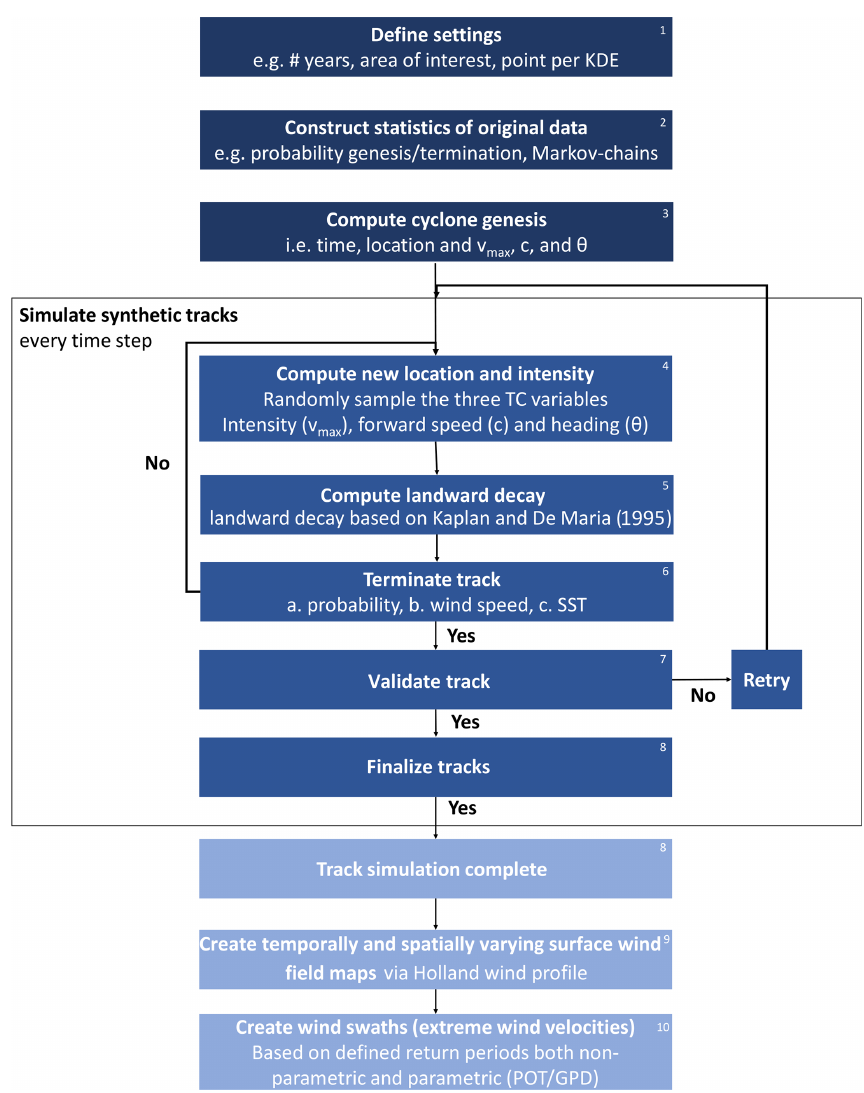
Figure 1. Flowchart of the track modeling procedure. Dark blue colors are pre-processing steps, blue colors the computational core of TC- WiSE and light blue post-processing steps. KDE stands for kernel density estimation, SST stands for sea surface temperature and POT/GPD is the acronym of peak over threshold and generalized Pareto